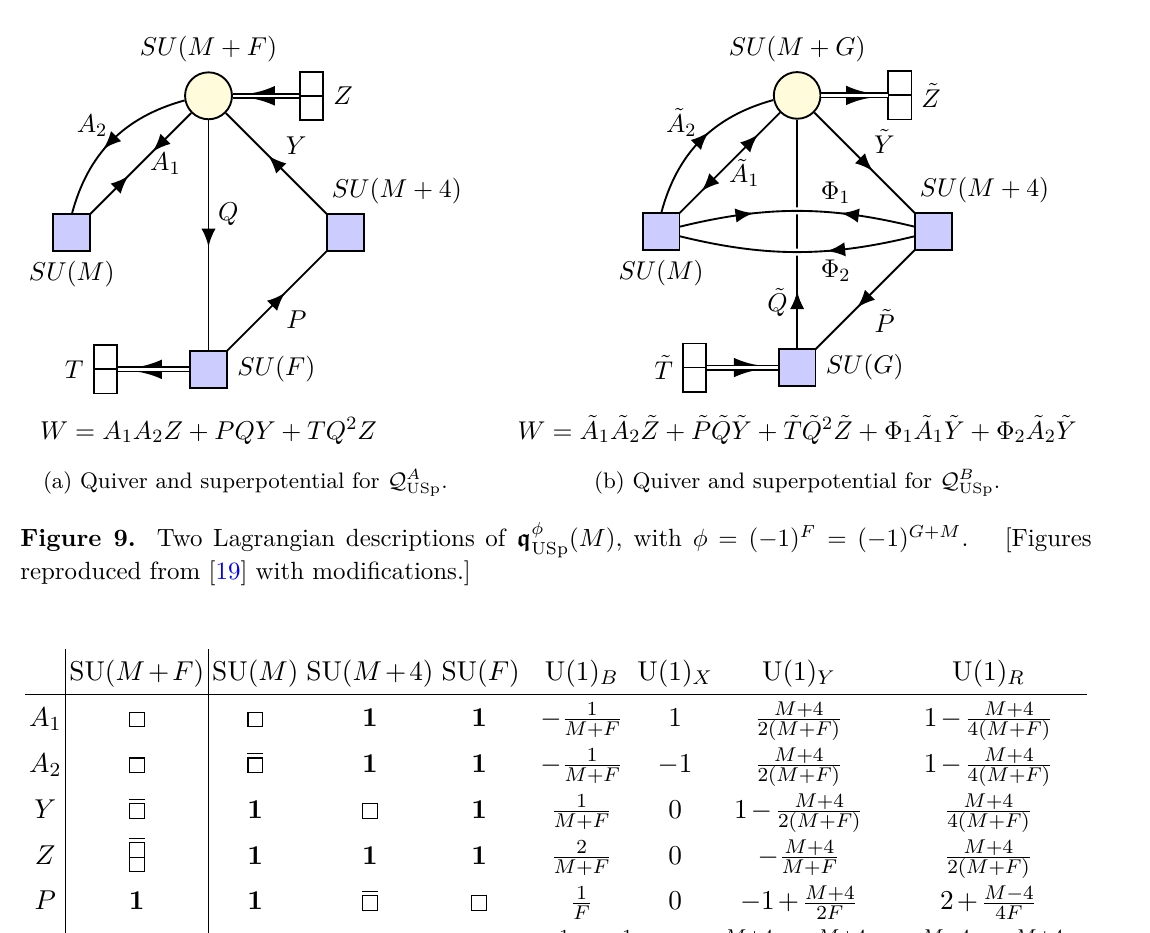
Table 1. The charge table for Q A (cid:0) M +4 (cid:1) y 2 − 1 U(1) B where y M is the middle root of 9( M +4) y 3 M 4 3 varying between y 0 = 0 and y ∞ ’ − 0 . 1018